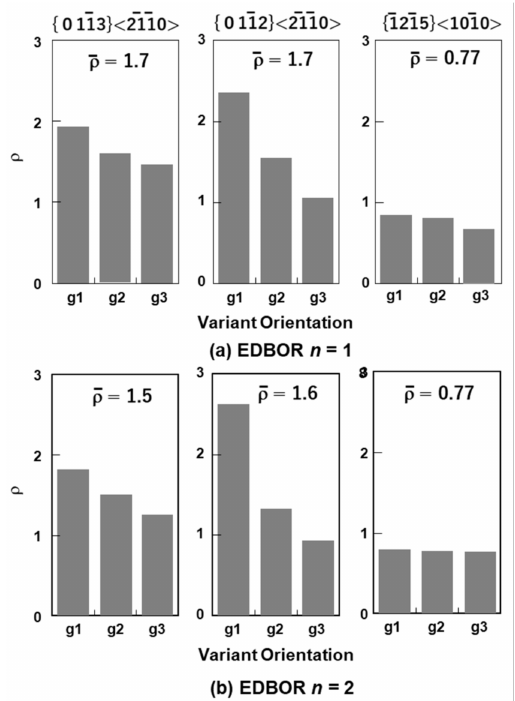
(cid:8) (cid:9)(cid:10) (cid:11) (cid:8) (cid:9)(cid:10) (cid:11) 0113 2110 , 0112 2110